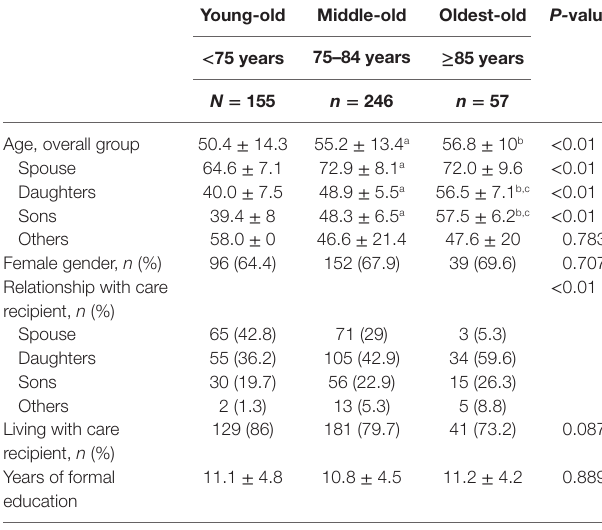
TaBle 3 | Comparison of caregiver characteristics.